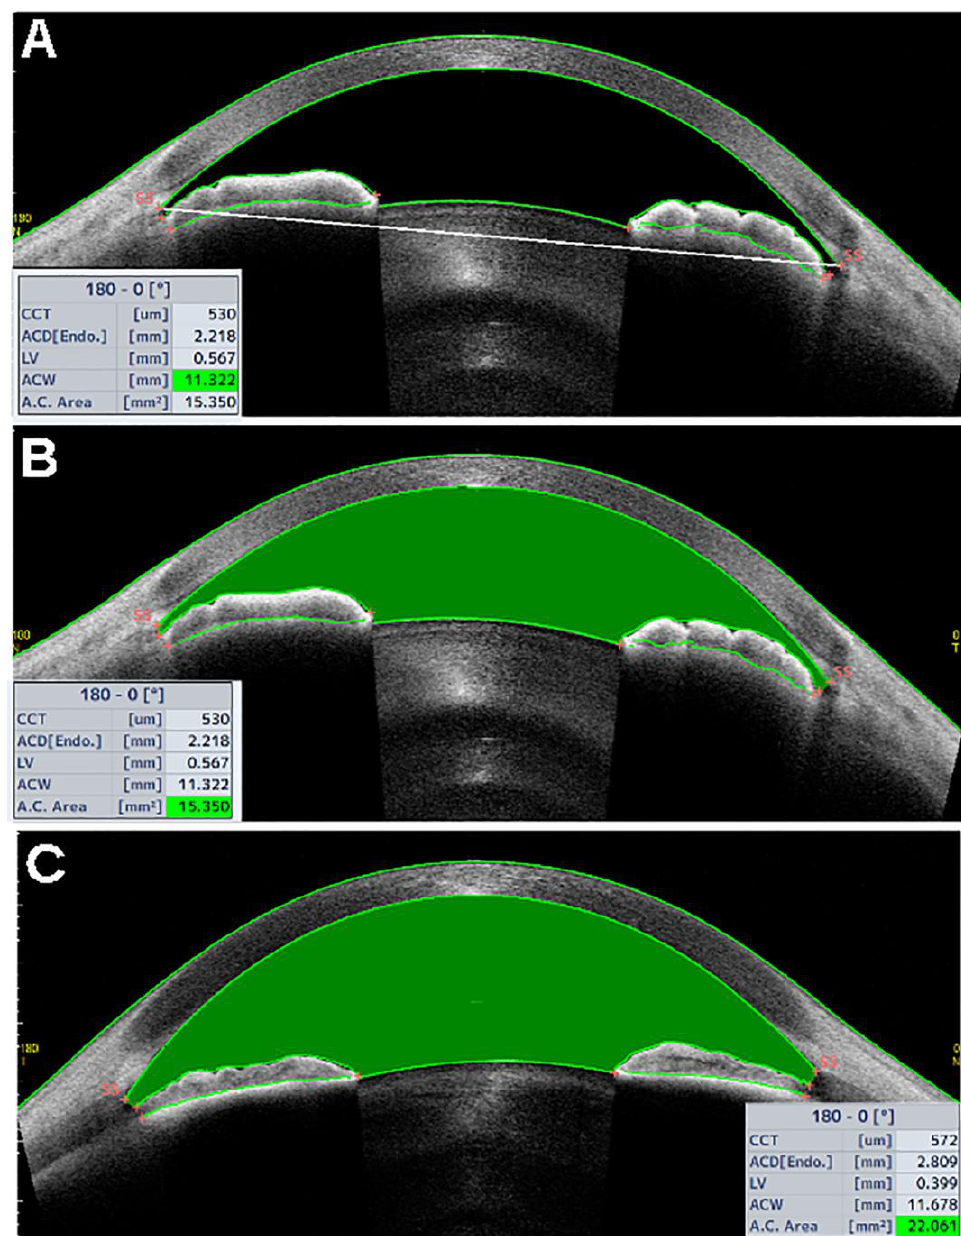
Figure 2. Tomey Casia 2 AS-OCT scans (Nagoya, Japan). ( A ) The white, bold horizontal line corresponding to the scleral-spur-to-scleral-spur line shows the anterior chamber width (ACW) and measures 11.322 mm in this patient with narrow angles. ( B ) The green area, delimited by the corneal endothelium anteriorly, and the anterior surface of the iris and lens posteriorly, corresponds to the anterior chamber area (ACA) and measures 15.35 mm 2 in the same patient with narrow angles. ( C ) The ACA from a patient with open angles.